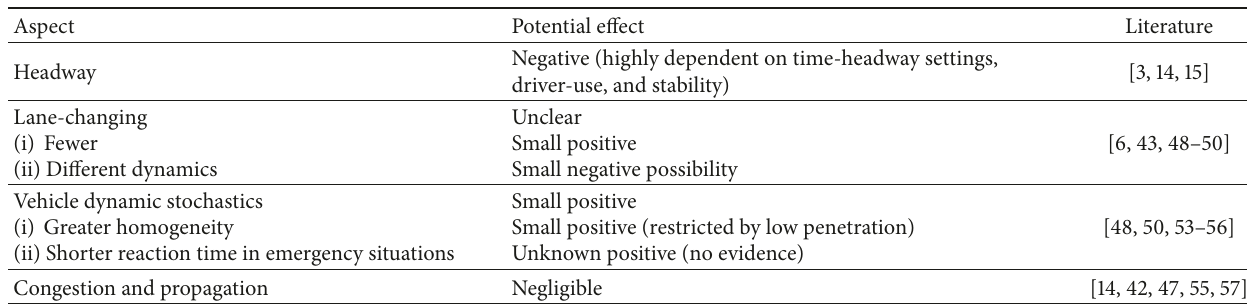
Table 1: Traffic flow